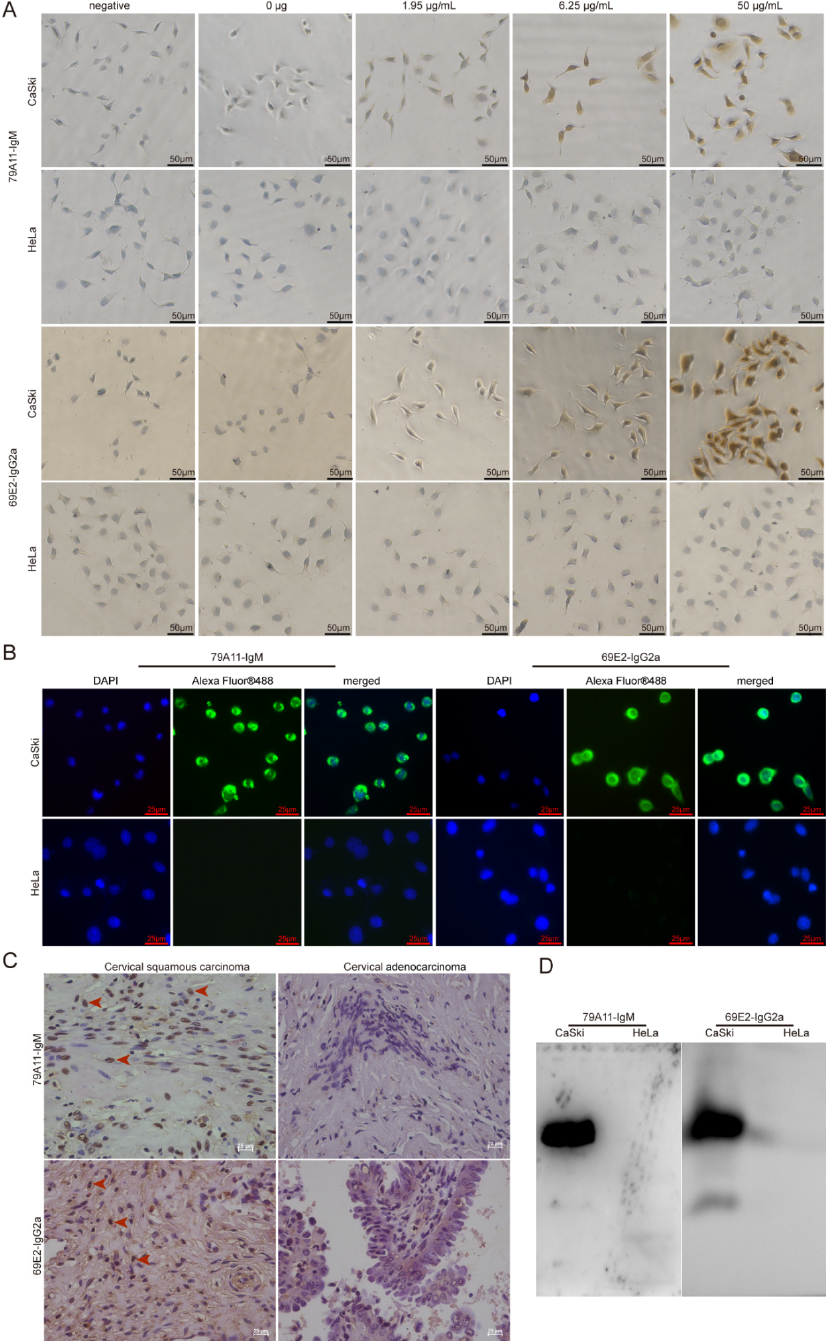
Figure 4. E ff ectiveness and specificity of the anti-HPV16 E7 protein mAbs identified by using immunocytochemistry, immunofluorescence, immunohistochemistry, and Western Blot. ( A ) The 79A11 and 69E2 antibodies at the three dosages of 1.95, 6.25, and 50 µ g / mL, respectively, were used to react with the HPV16-type cervical cancer cell line CaSki and the HPV18-type cervical cancer cell line HeLa in immunocytochemical reactions. ( B ) The 79A11 and 69E2 mAbs, respectively, reacted with the CaSki and HeLa cervical cancer cell lines at a dose of 10 µ g / mL in IF experiments. ( C ) The 79A11 and 69E2 mAbs reacted with the para ffi n sections of HPV16 cervical squamous cell carcinoma and HPV18 cervical adenocarcinoma tissues at 8.95 and 50 µ g / mL, respectively, in IHC assays. ( D ) The 79A11 and 69E2 mAbs reacted with CaSki cell protein extract at 10 µ g / mL, respectively, in Western Blot experiments. IF, immunofluorescence; IHC,